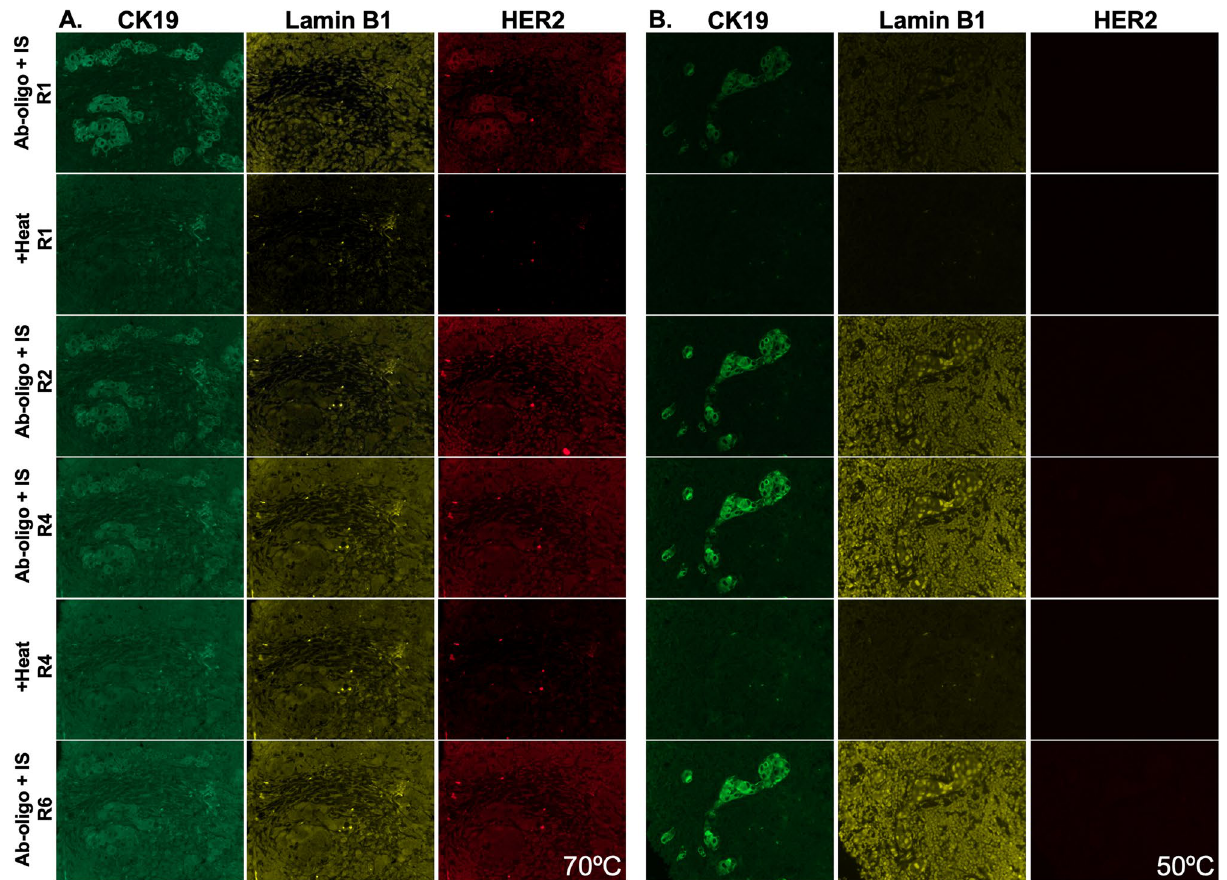
Figure 6. Effect of thermal denaturation on background fluorescence. Tissues were stained with CK19, Lamin B1 and HER2 Ab-oligo conjugates and then incubated with ( A ) 28 nt or ( B ) 13 nt length IS. Signal was removed by heating the sample to either 70 °C or 50 °C for 28 or 13 nt IS, respectively. Each sample was subjected to six rounds of IS application, imaging and thermal